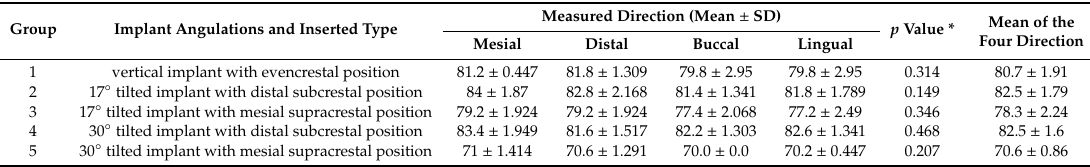
Table 1. ISQ in the five groups.